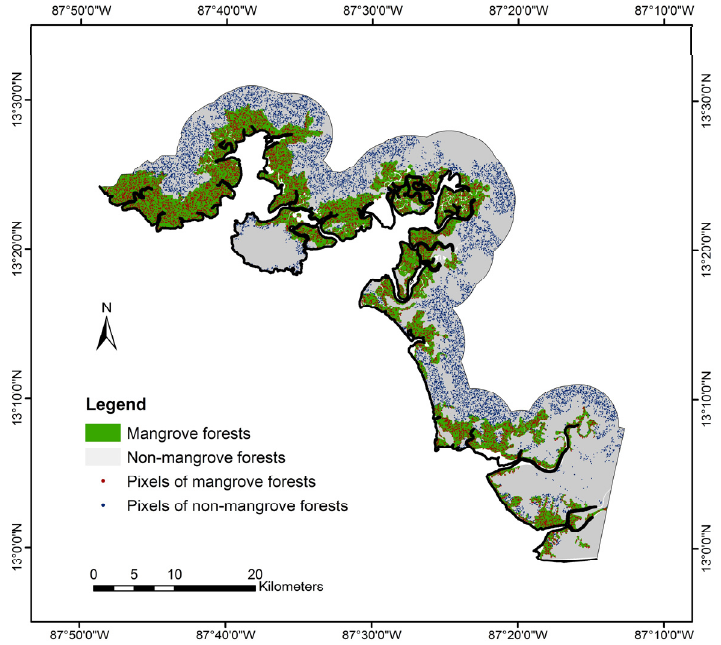
Figure 2. Map showing the mangrove forests in the study area extracted from the 2002 land-use map. The dark red and blue pixels randomly extracted from this map were used for computing the Jeffries-Matusita distance ( JM) and accuracy assessment of the 2002 classification